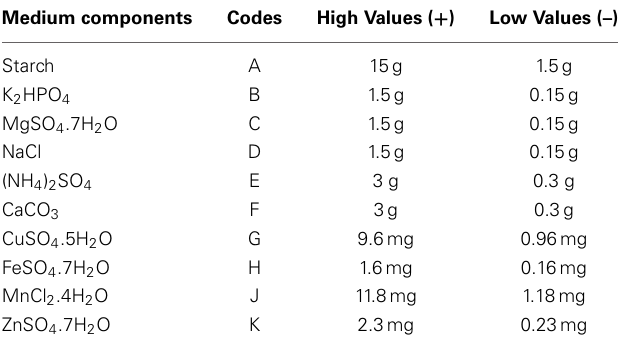
Table 3 | Media components (variables), their codes and levels involved in PBD.